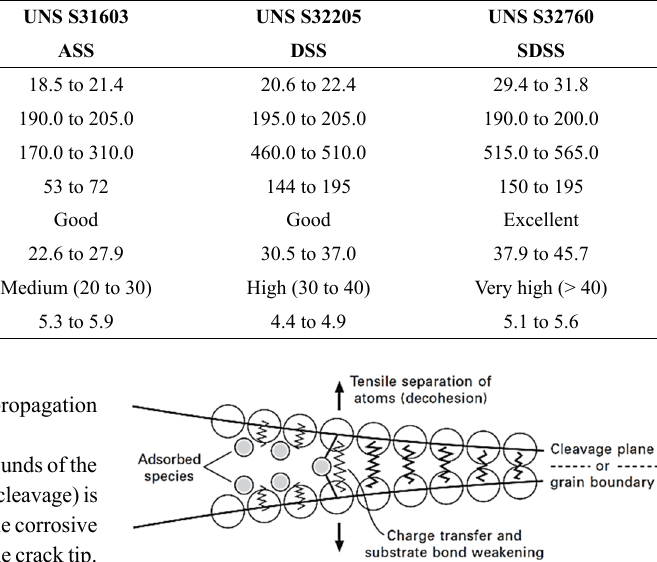
Figure 1. SCC mechanism: tensile decohesion of the atomic bounds due to the presence of adsorbed ions in the crystal lattice ahead of the crack tip 4 .